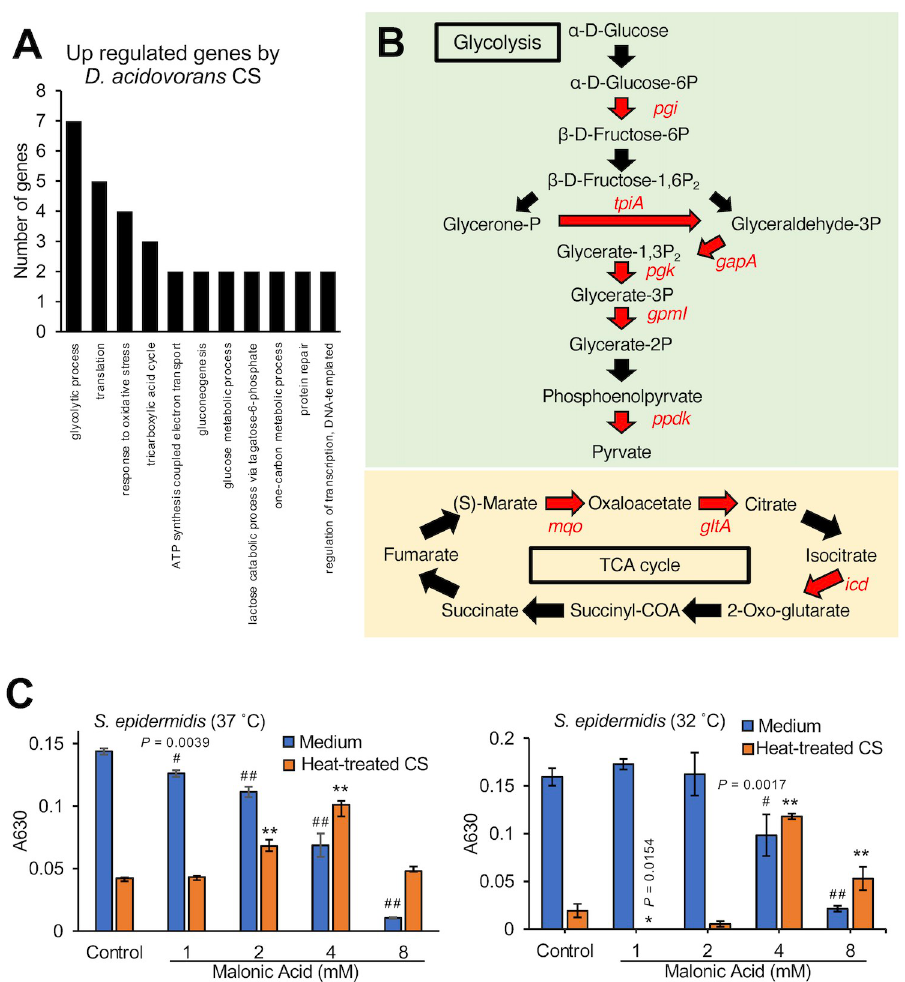
Fig 4. Suppressive effect of a TCA cycle inhibitor on the inhibitory effect of heat-treated culture supernatant of D . acidovorans against S . epidermidis growth. (A) Gene expression analysis of S . epidermidis (1 × 10 9 cells/mL) mixed with 50% D . acidovorans CS at 37˚C for 4 h. The graphs show the number of upregulated genes in S . epidermidis after D . acidovorans CS treatment. (B) Upregulated genes related to glycolysis and the TCA cycle. Red letters represent genes that increased more than 2-fold after treatment with D . acidovorans CS in S . epidermidis . (C) S . epidermidis (1 × 10 4 cells/mL) in NB was mixed with 1–4 mM malonic acid and 15% D . acidovorans heat-treated CS (Heat-treated CS). After incubating at 37˚C for 12 h or 32˚C for 18 h, absorbance at 630 nm was measured using a microplate reader. Error bars indicate the SD of the means (n = 3). Statistical differences of each group were analyzed by the Dunnett test. ( # : P < 0.05 (Medium), # # : P < 0.001 (Medium), � : P < 0.05 (Heat-treated CS), �� : P < 0.001 (Heat-treated CS)).